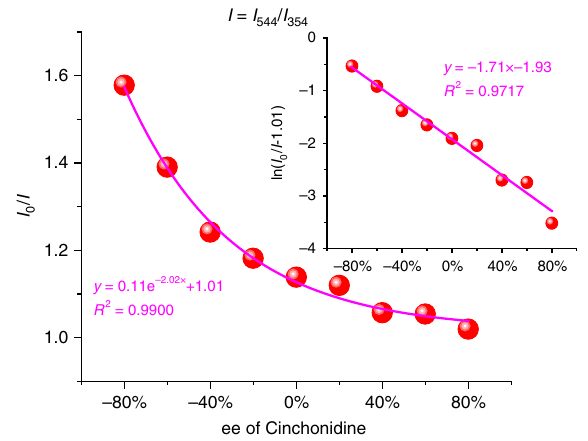
Fig. 3 ee values with fl uorescence intensities. Fluorescence intensities of Zn-MOF-C-Tb in DMF suspension versus ee values of Cinchonidine. Inset: the natural logarithm of the data. I in this fi gure is I 544 / I 354